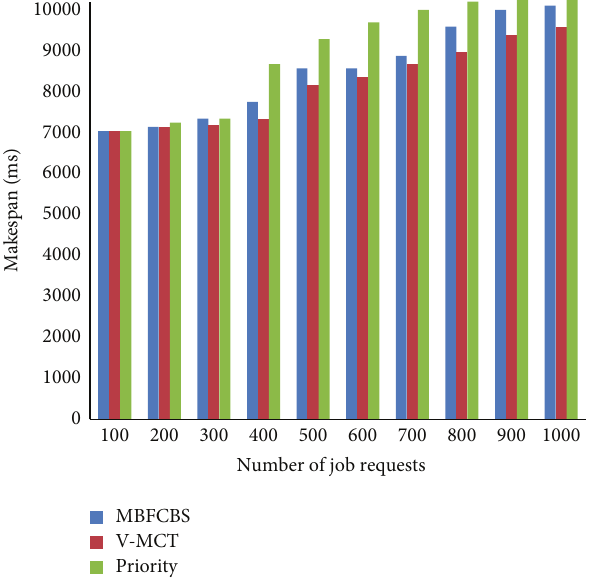
Figure 11: Makespan of scheduling